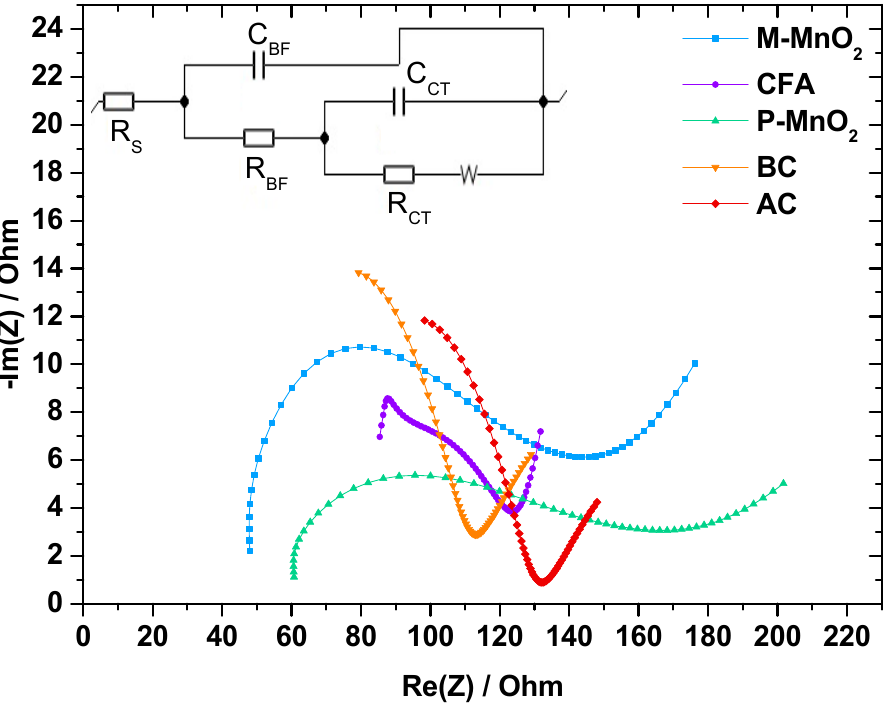
Figure 7. Nyquist (Bode-Bode) plots from EIS